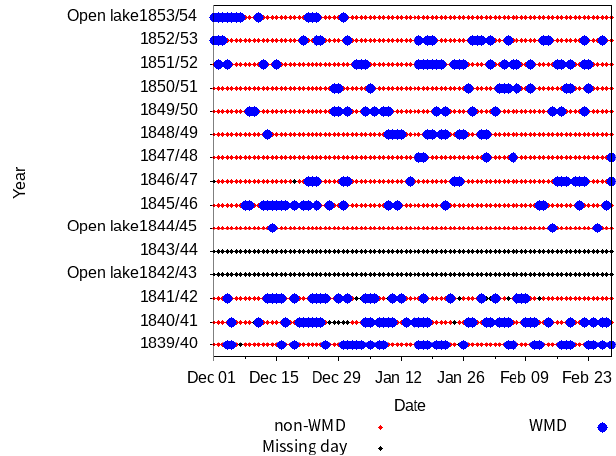
Figure 12. Winter monsoon outbreak days (WMDs) for the years 1839/40–1853/54. The blue dots indicate WMDs, the red dots indi- cate non-WMDs, and the black dots indicate days with no